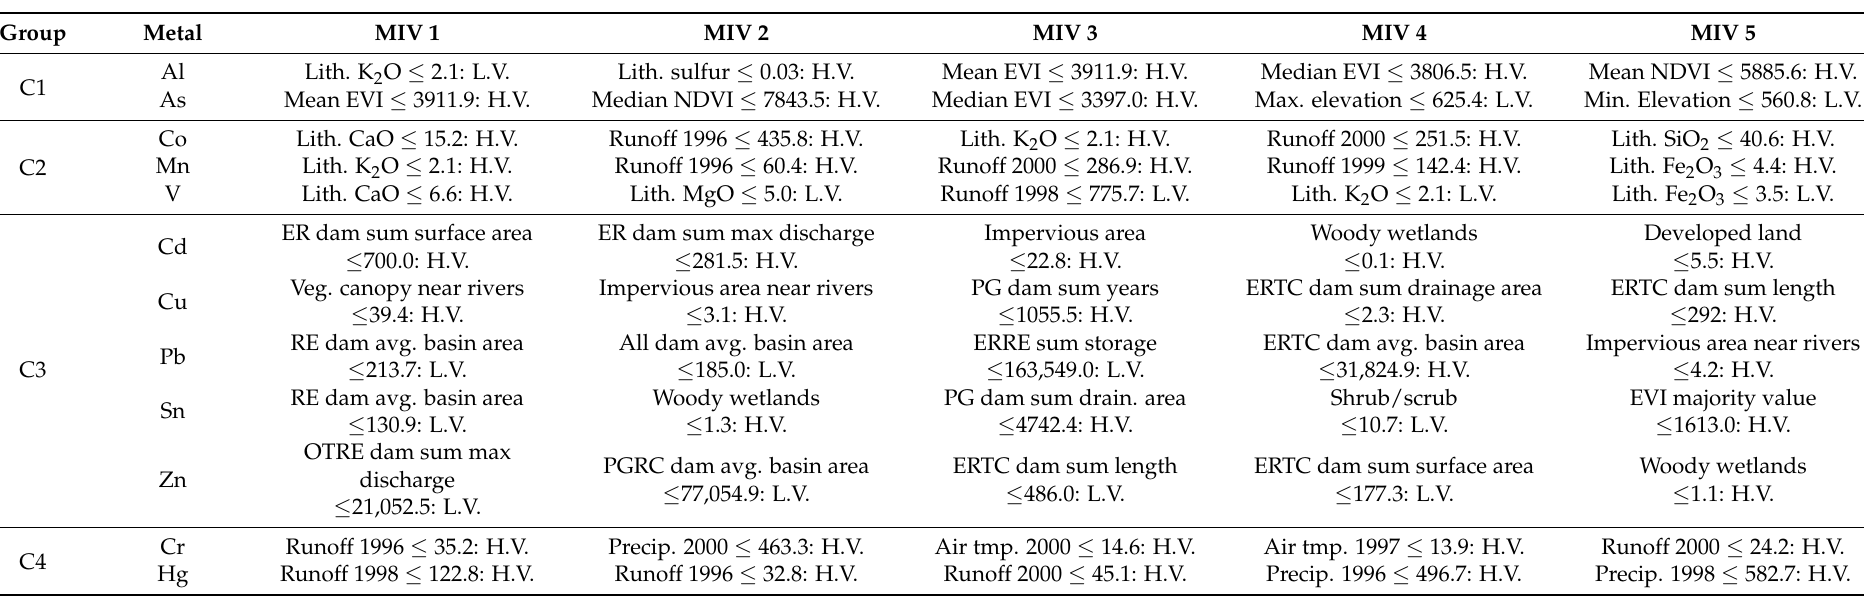
Table 4. The five most important MIV for each group, the split threshold for the decision rule, and the outcome if the respective value is below or equal to the threshold.